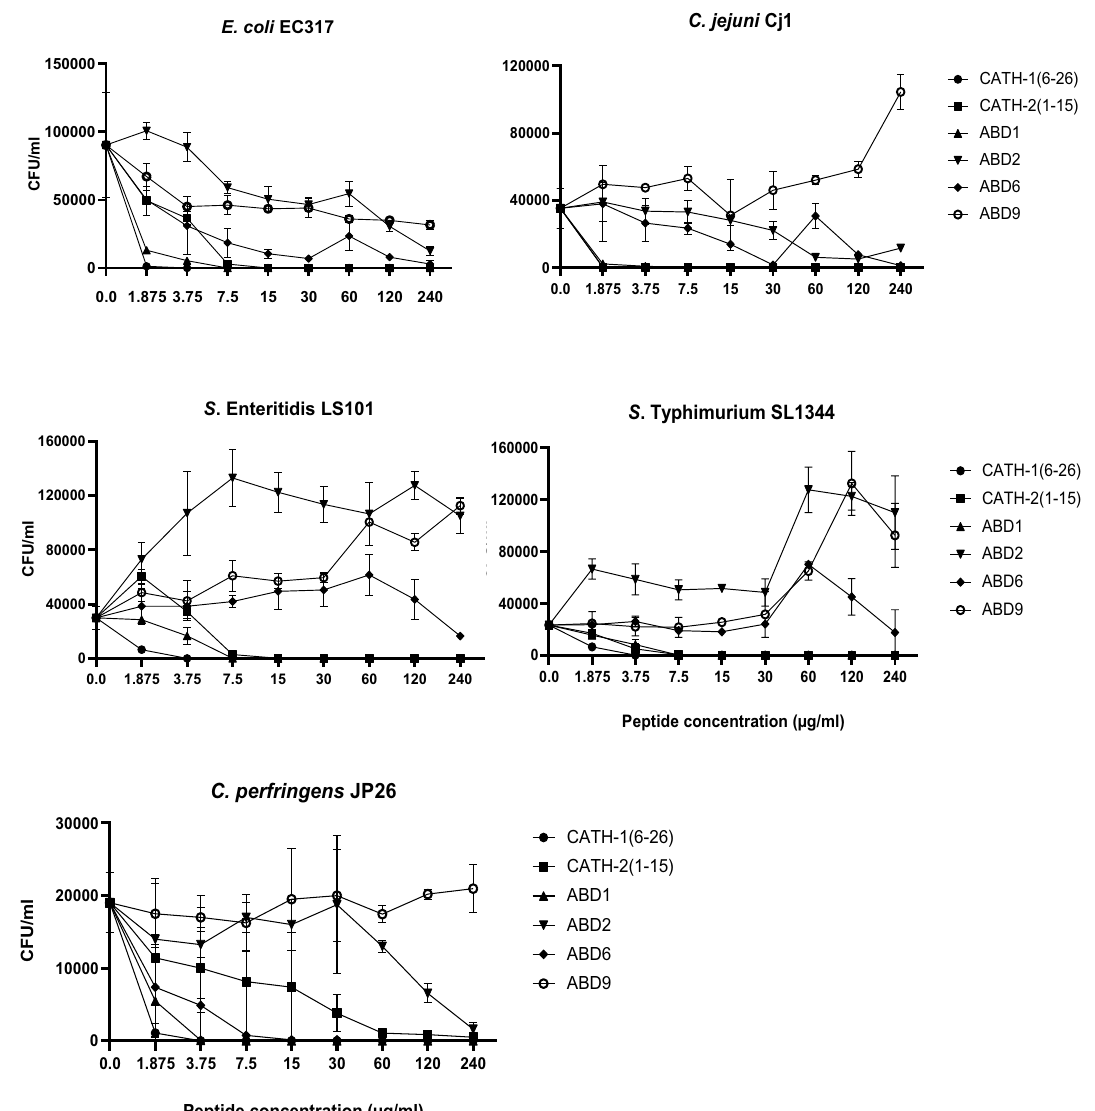
Figure 2. Antibacterial activities of 6 synthesized peptides against five important pathogenic bacteria isolated from birds. In each experiment, respective bacterial species (from 10 4 to 10 5 CFU/ml) were incubated for 2 h with peptide concentrations ranging from 1.875 to 240 µg/ml in duplicate, serially diluted, and plated on agar media. The data is shown as mean ± SD of at least two independent experiments on different days.